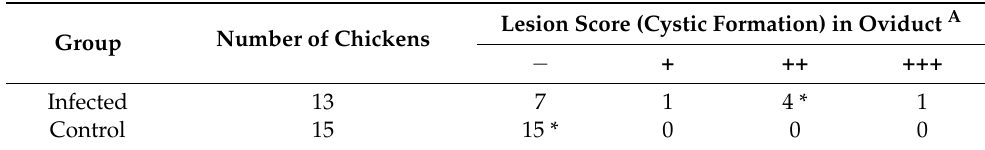
Table 1. Comparison of the cystic lesions in the oviduct between the infected and control groups at 16 weeks of age following infection at 1-day of age.